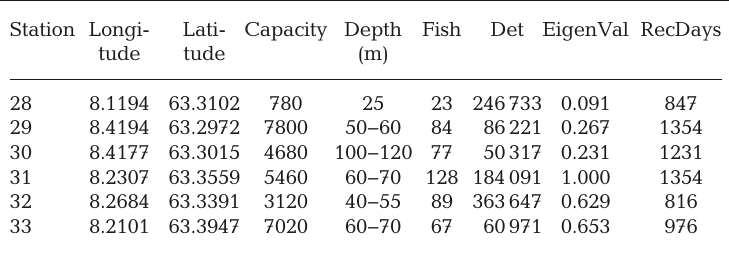
Table 8. Summary statistics for the farms (station numbers). Longtitude and latitude gives the geographical location of the farms in decimal degrees. Capacity: maximum standing biomass; depth: bottom depth underneath the farms. Number of fish detected and number of detections across the study are also shown. EigenVal: the eigenvalue centrality of the different stations/farms in the network analysis (i.e. how central the farm is in the network). The latter was calculated using data from 13 February 2017−31 May 2019 only, whereas number of fish and detections are totals from 13 February 2017−30 October 2020. RecDays: number of days data was recorded at each Station Longi-